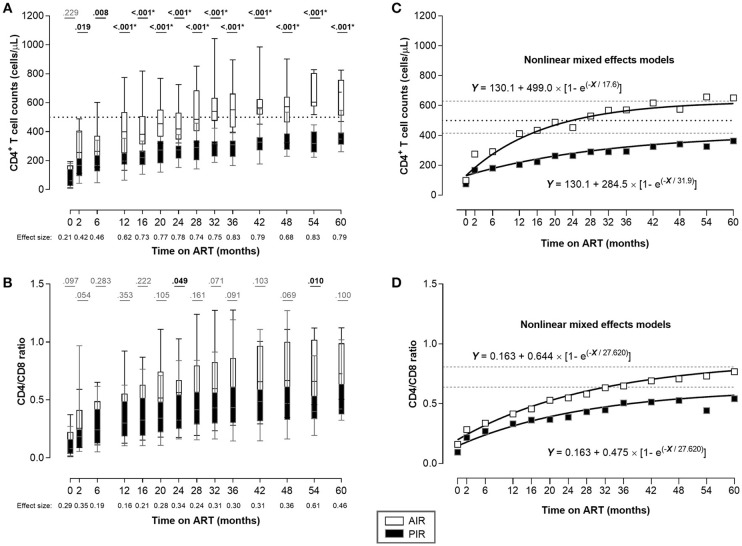
Despite having similar CD4+ T cell counts at ART onset, AIR reached higher CD4+ T cell counts as soon as 2 months after ART initiation. (A) CD4+ T cell counts and (B) CD4/CD8 ratio were compared throughout ART between AIR and PIR. A Wilcoxon-Mann-Whitney U-test was performed to compare the two groups of patients at each time point, and the correspondent r is presented as a measure of effect size. *Significant after Bonferroni correction (α/14 = 0.004). (C,D) Nonlinear mixed effects models for CD4+ T cell count and CD4/CD8 ratio evolutions, respectively. White squares represent AIR mean of CD4+ T cell count (C), or CD4/CD8 ratio (D) at each time point; black squares represent PIR mean of CD4+ T cell count (C), or CD4/CD8 ratio (D) at each time point. Black dotted lines in (A) and (C) correspond to Y = 500. Gray dashed lines correspond to the asymptotes: Y = 629.1 and Y = 414.6 (C); Y = 0.807 and Y = 0.638 (D), respectively.